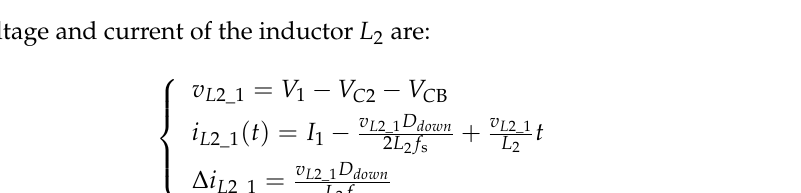
The voltage and current of the inductor L 2 are: